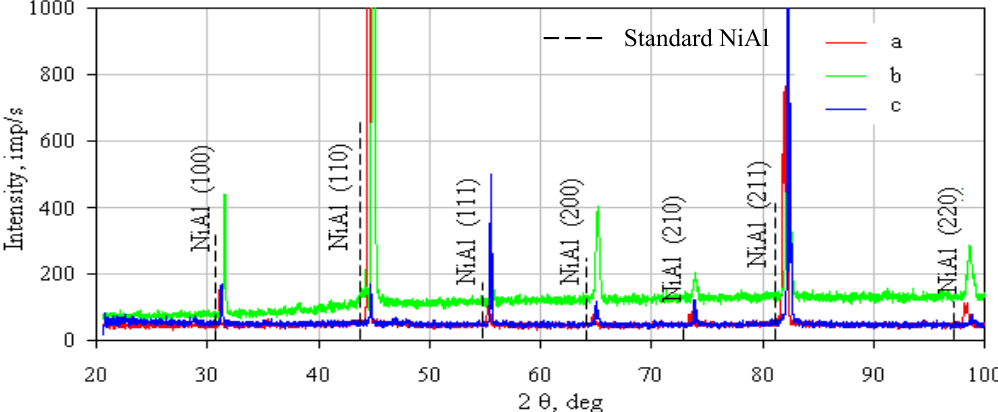
Figure 2. Microstructure ( a ) and elements’ distribution ( b ) on the cross-section of the nonmodified aluminide coating.